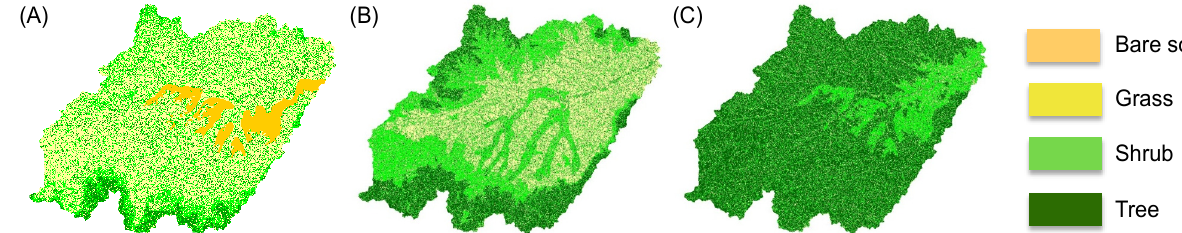
Figure 3. Examples of vegetation maps derived for the Upper Rio Salado basin for three different combinations of rainfall parameters. Maps are obtained using the measured rainfall rate ( λ = 0.284 day − 1 ) and changing the parameter α that assumes the following values: ( A ) 0.474 cm; ( B ) 0.517 cm; ( C ) 0.631